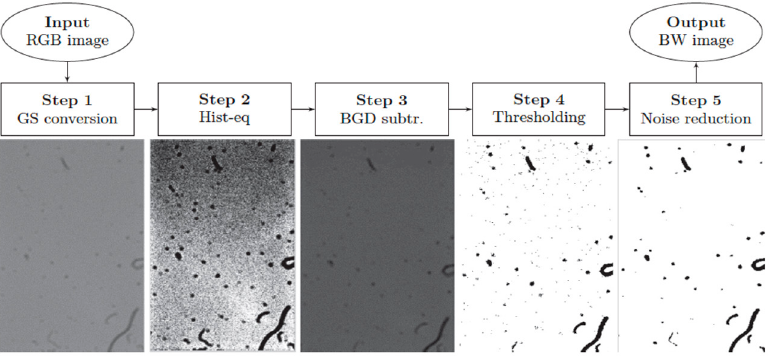
Figure 13. The preprocessing steps for detection of the particles. Adapted with permission from [92]. © 2021 Elsevier.